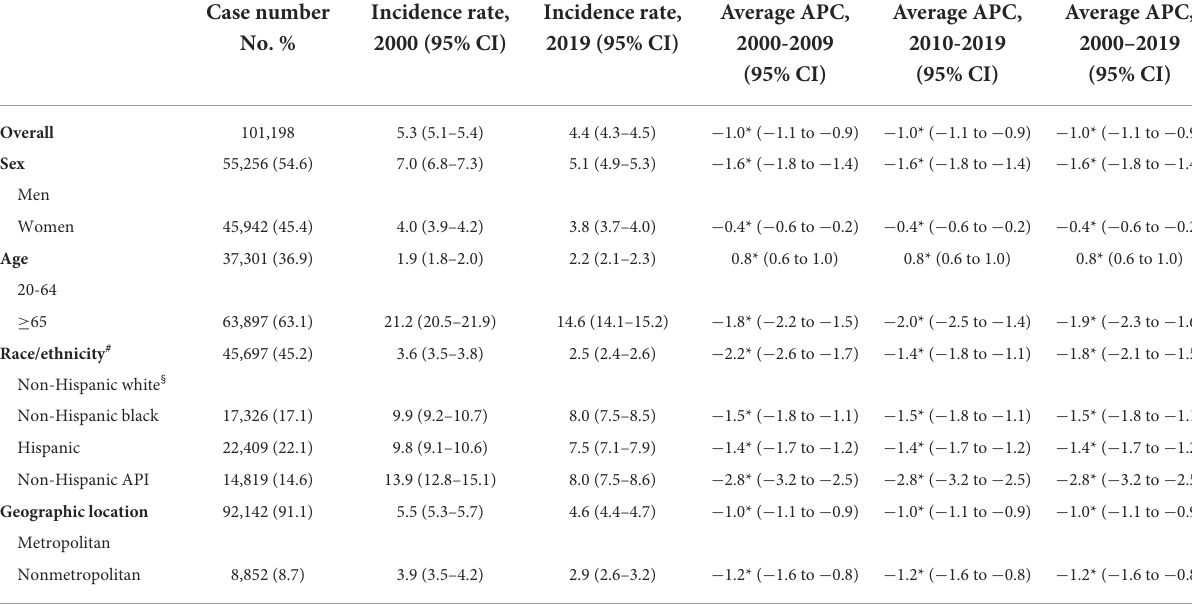
TABLE 1 Incidence rate and trend in non-cardia gastric cancer among US adults aged ≥ 20,